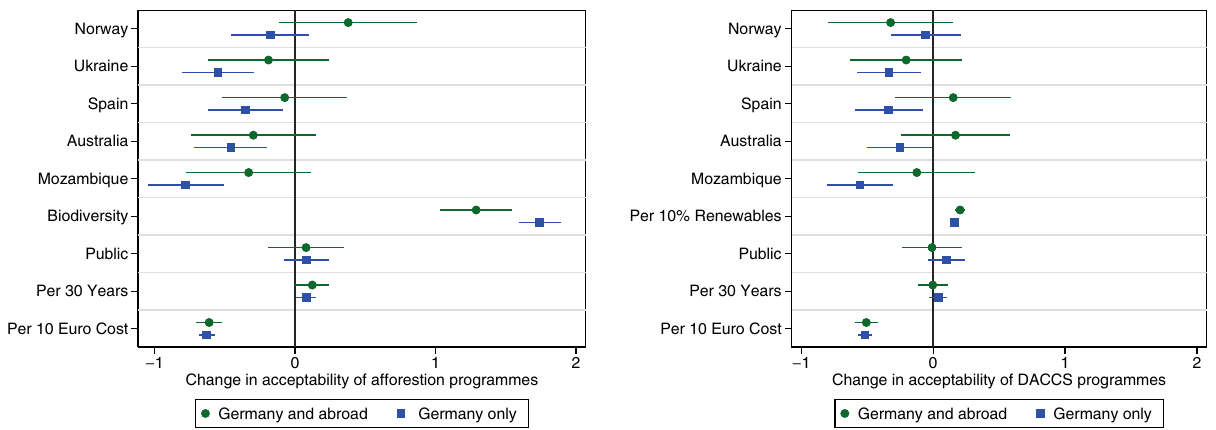
Fig. 5 Effects of carbon dioxide removal (CDR) characteristics on acceptability of CDR methods, depending on whether respondents supported programmes in Germany and abroad (25%) or only in Germany (75%). Presented on the y -axis are effects (dots and 95% CIs) of vignette attributes (country, environmental characteristics, public vs. private, guaranteed permanence of storage, and costs to households, compare Table 1) on changes in support measured on a 11-point scale ( x -axis). The results are based on random effects models; n = 409 for the model “ Germany and abroad ” and n = 1280 for the model “ Germany only ” . Positive effects refer to an increase in acceptability and negative effects to a decrease. The effects for the categorical variables (country, public vs. private, biodiversity) are relative to the respective base category (Germany, monoculture, private actor). For full regression tables see Tables S1 and S2 in the suppl.